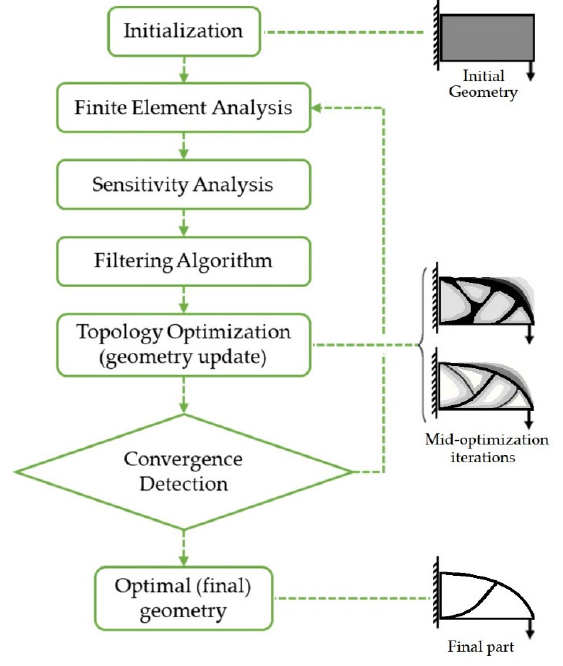
Figure 5. Topology optimization specific schematic workflow.